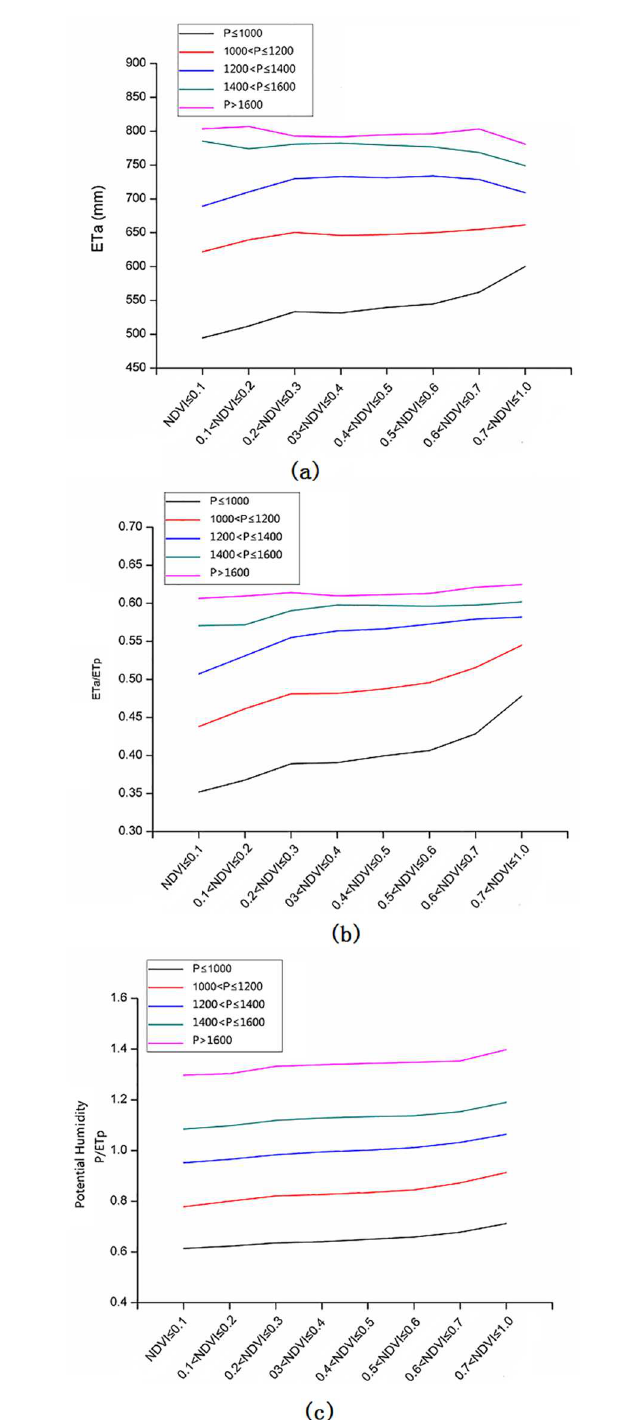
Fig 4. The (a) actual evapotranspiration (ETa), (b) evapotranspiration efficiency (ETa/ETp) and (c) potential humidity (P/ETp) responses to the NDVI and precipitation